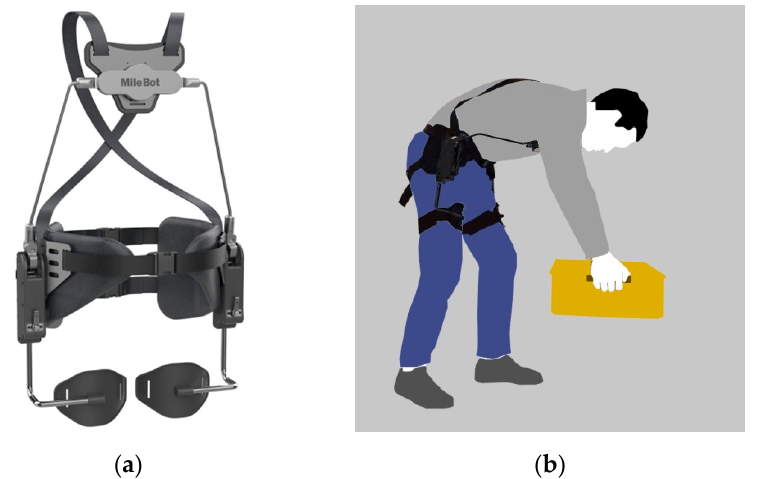
Figure 1. The passive exoskeleton. ( a ) Structure of the passive exoskeleton; ( b ) human–machine interaction of the passive exoskeleton.